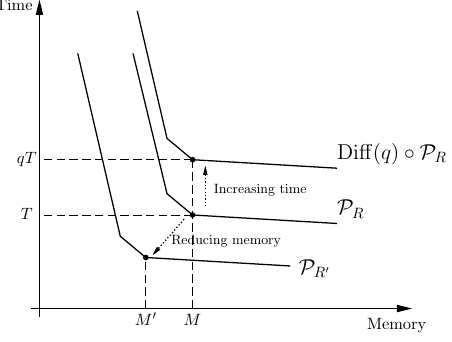
Fig. 1. Time and memory requirements for proof-of-work. The problem with parameters R can be solved in time T and memory M . In order to change M to M (cid:48) , we replace R with R (cid:48) . To increase time by the factor of q , we add the difficulty filter q in addition to R